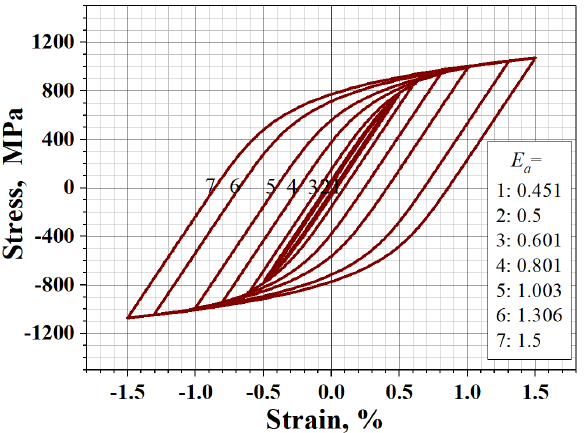
Figure 1. Steady stress–strain loops of GH4169 at 500 °C (according to the test data from ref. [33]).